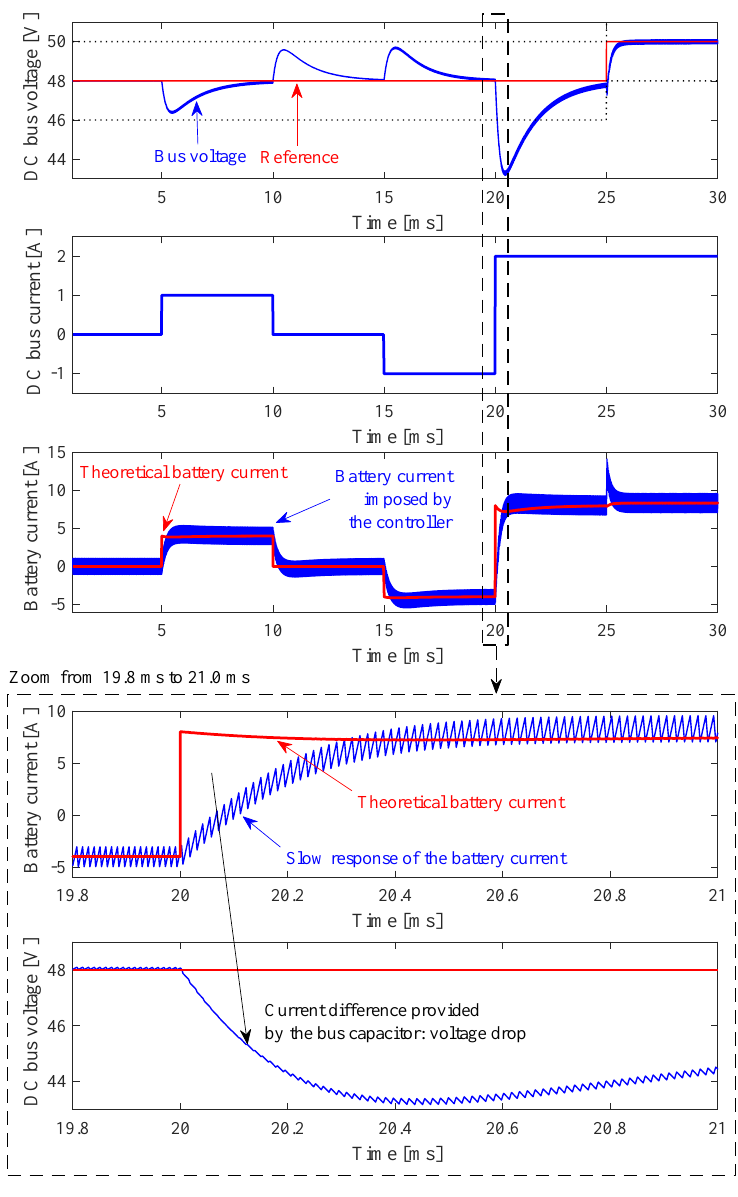
Figure 4. Simulation of the controller presented in